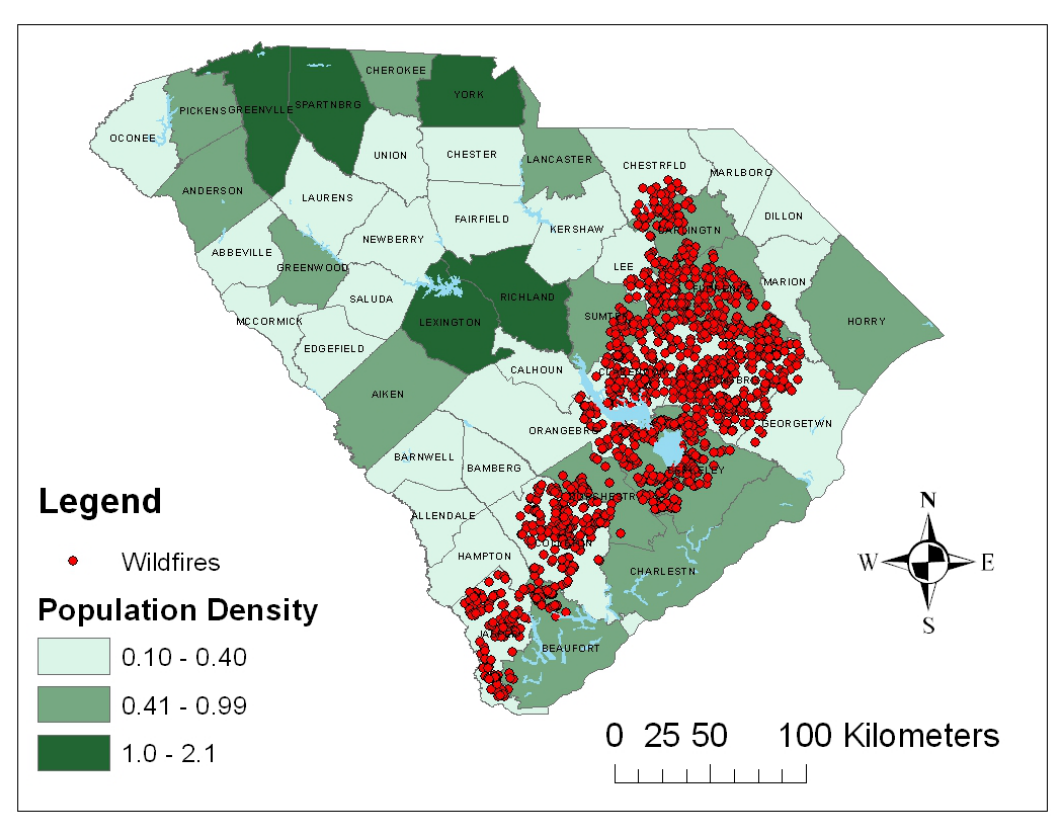
Figure 6. Population density per ha of each county in South